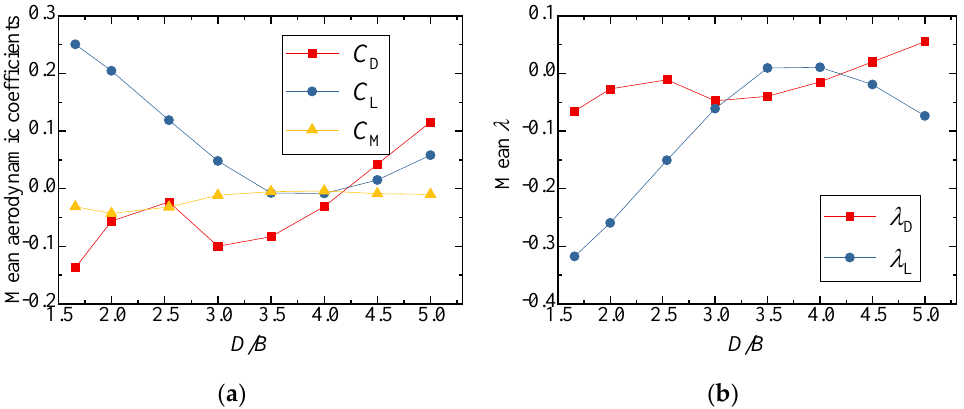
Figure 24. Aerodynamic coefficients and interference factors for Case 4: ( a ) Mean value of the downstream bridge; ( b ) Interference factor for the downstream bridge.